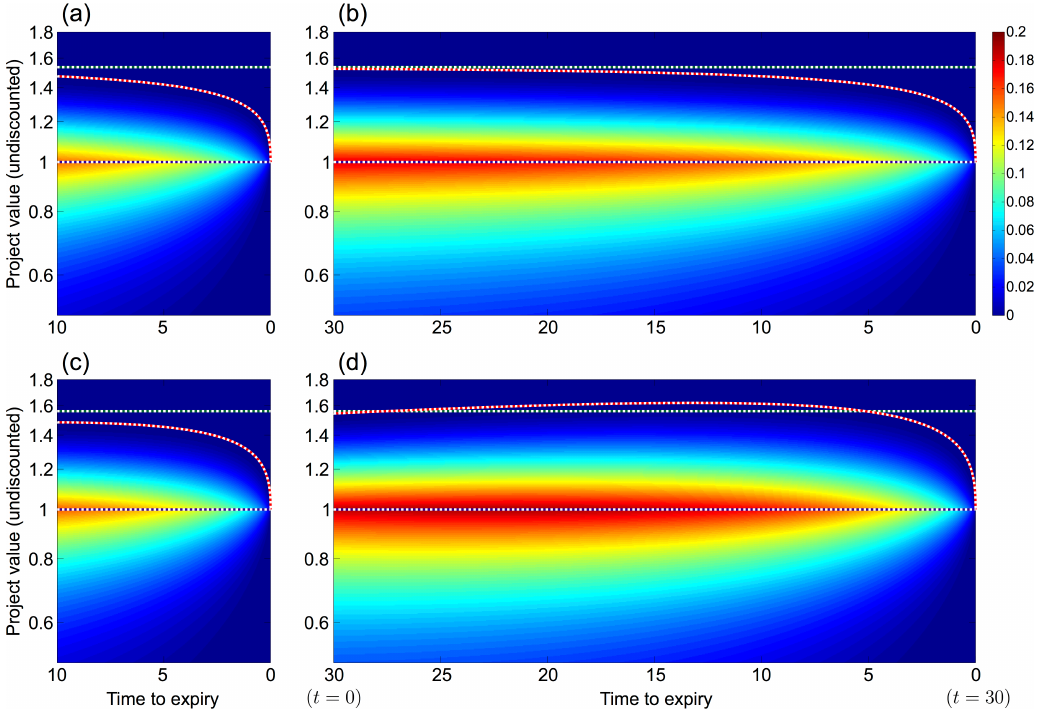
Figure 2. ( a ) Case T = 10, α = i . Colour scale represents the undiscounted time value of the real option. The vertical axis (undiscounted project value) is plotted with a logarithmic scale. Time is plotted on the horizontal axis. Blue line: at the money; Red line: exercise threshold; Green line: Infinite-maturity exercise threshold; ( b ) Case T = 30, α = i ; ( c ) Case T = 10, r = i ; ( d ) Case T = 30, r = i . Exercise threshold at t = 0: ( a ) 1.4731; ( b ) 1.5226; ( c ) 1.4816; ( d ) 1.5425. Option value at the money ( t = 0): ( a ) 0.1531; ( b ) 0.1797; ( c ) 0.1564; ( d ) 0.1881. Calculation time (backwards induction step): ( a ) 1.37 s; ( b ) 5.37 s; ( c ) 1.38 s; ( d ) 5.31